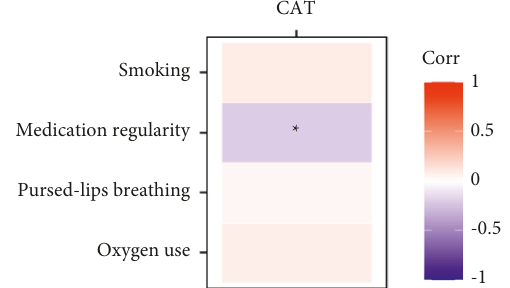
Figure 3: Correlation of CAT with self-management